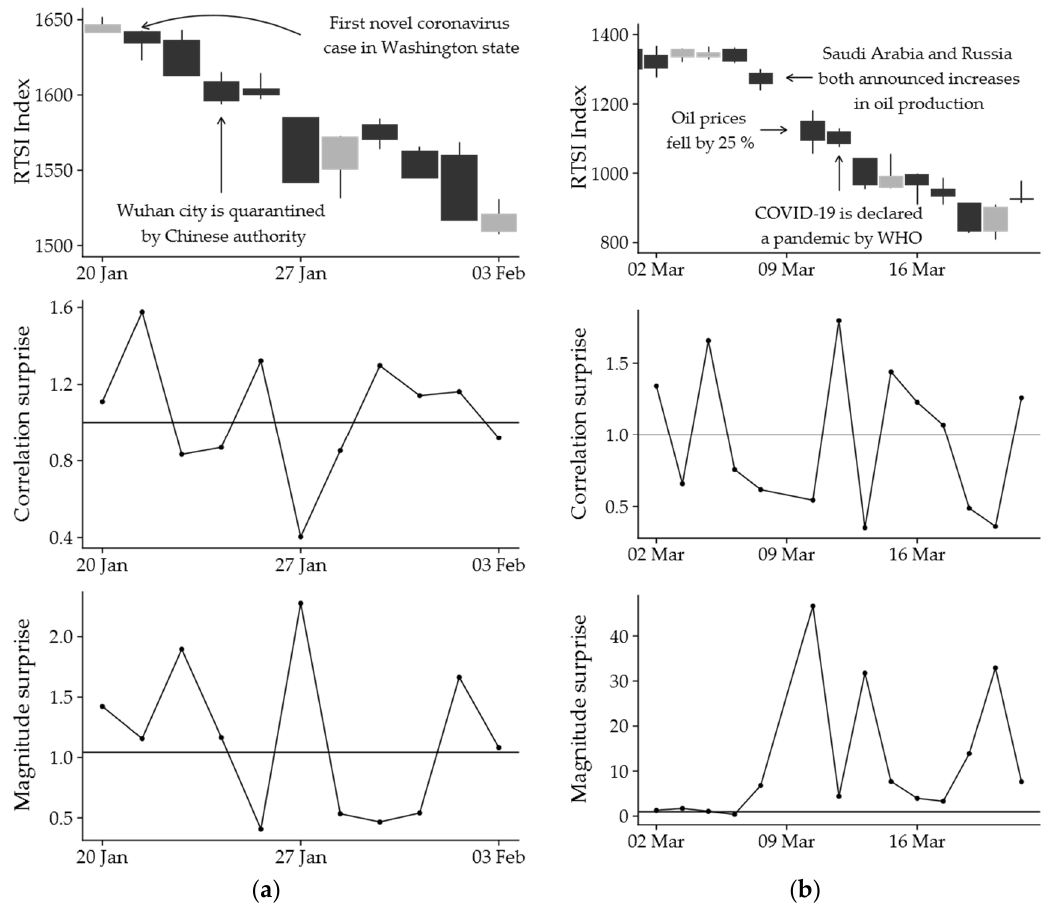
Figure 7. Analysis of the financial turbulence: ( a ) January–February, ( b ) March 2020.